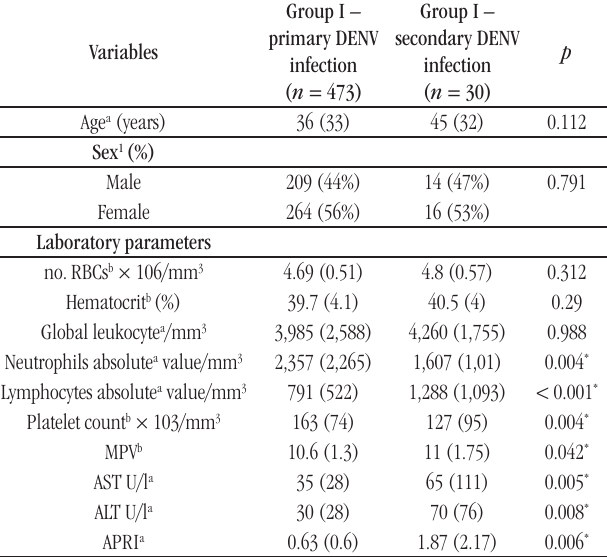
taBLE − Comparison of demographic and laboratorial variables between the